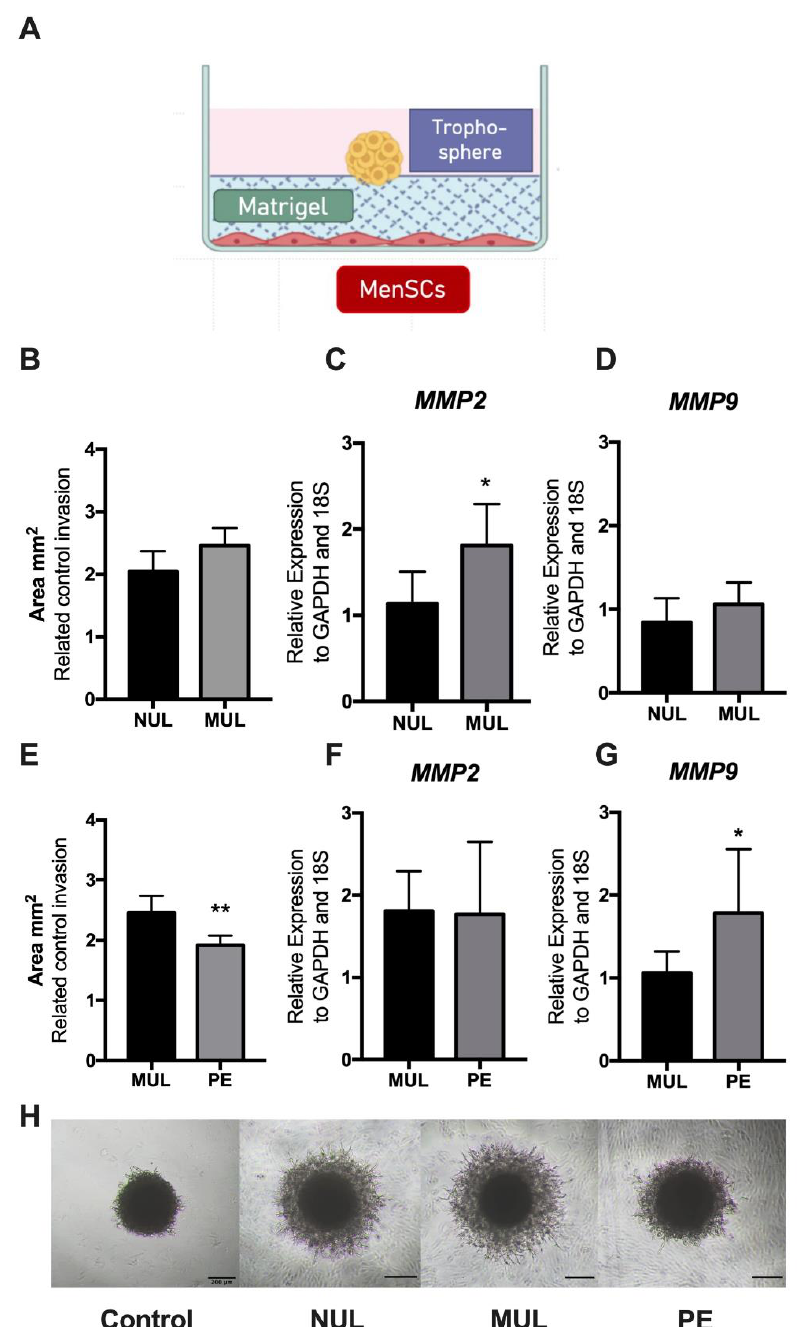
Figure 4. In vitro 3D model of trophoblast invasion. ( A ) Schematic depicts the components of the model: MenSCs on the bottom of the plate as a monolayer of endometrial cells. Matrigel mimics the extracellular matrix, and trophospheres mimic the trophectoderm of a blastocyst that is transferred onto the Matrigel. ( B , E ) Invasion area of trophospheres co-cultured with MenSCs of nulliparous, multiparous, and PE women. Each area is expressed as relative to control invasion without MenSCs. Results are the means and SD of six MenSCs per group. ( C , F ) MMP2 and ( D , G ) MMP9 mRNA expression in trophospheres after invasion assay compared to the control invasion trophospheres. * p < 0.05, ** p < 0.01. Statistical analysis was performed by using the Mann–Whitney U test. ( H ) Representative images of trophospheres invasion after 72 h of co-culture with MenSCs. MenSCs, mesenchymal stem cells derived from the menstrual fluid, SD, standard deviation.